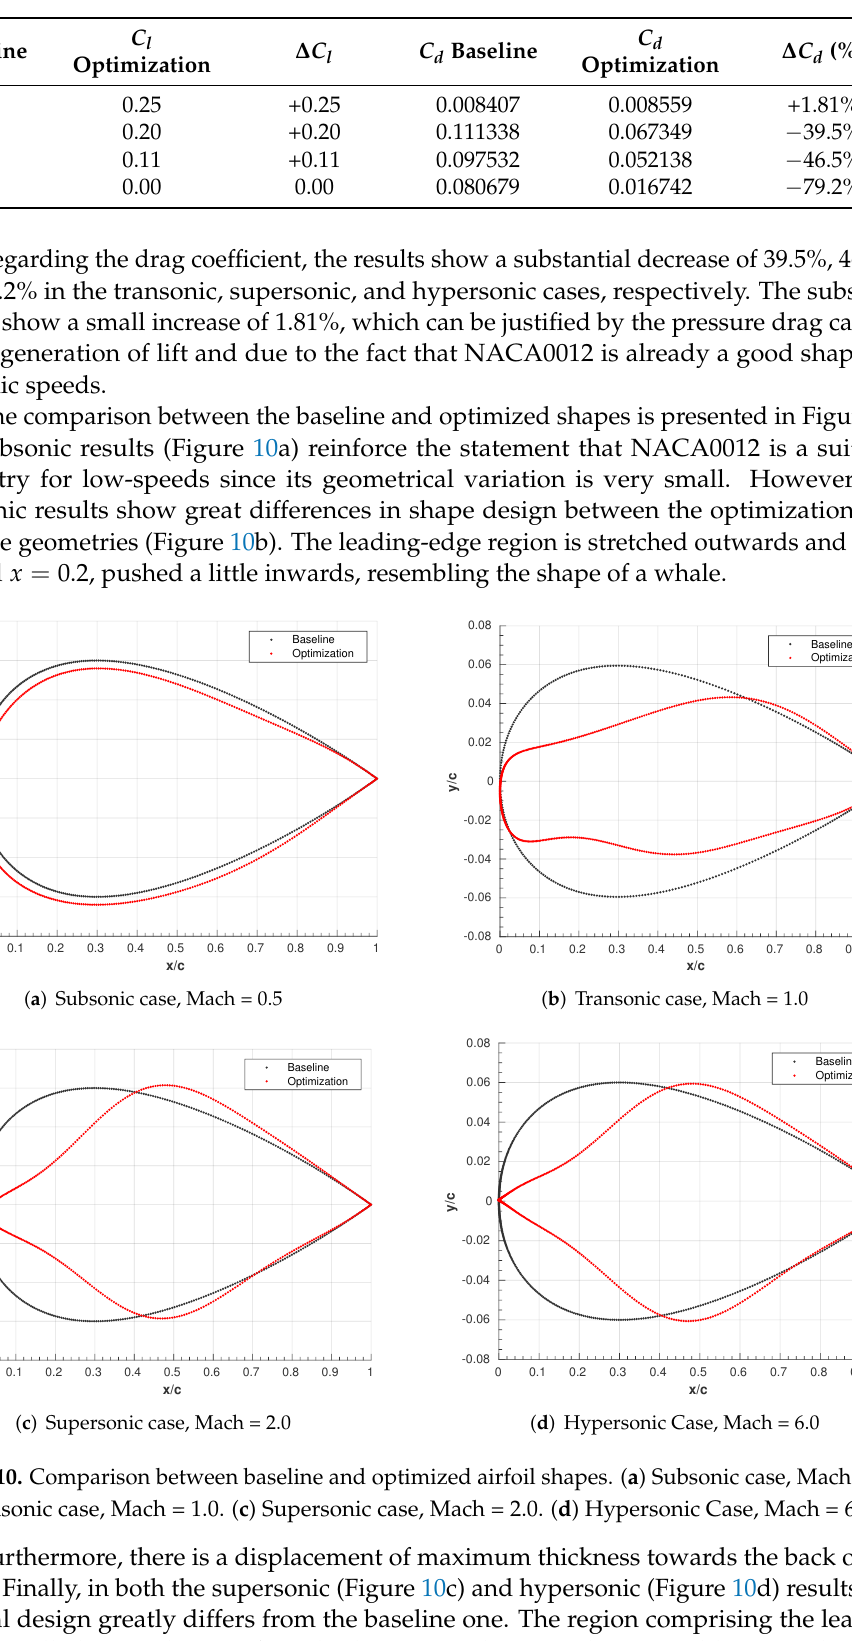
Table 3. Comparison between baseline and gradient-based optimization aerodynamic coefficients.